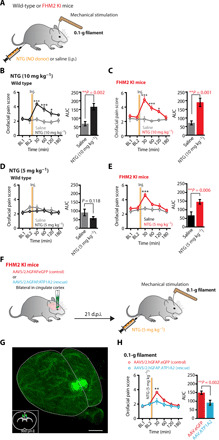
Local rescue of astrocyte dysfunction in the Cg reduces facial pain in FHM2 mice.(A) Schematic illustration of the experimental design. (B) Time course showing the orofacial pain score in WT mice injected with either saline (gray) or NTG (black). NTG (10 mg kg−1) elicits hypersensitivity to touch at 30, 60, and 120 min following injection. (C) Same as (B) but for FHM2 mice injected with saline (gray) or NTG (red). NTG (10 mg kg−1) evokes higher orofacial pain scores at 30, 60, and 120 min following injection. (D) A lower dose of NTG (5 mg kg−1) does not elicit a higher sensitivity in WT mice. (E) In FHM2 mice, NTG (5 mg kg−1) evokes a higher orofacial pain score at 30 min after injection. (F) Schematic illustration of the experimental design. (G) Three-dimensional reconstruction of a cleared brain imaged with light-sheet microscopy showing the volume and site of the injection in Cg after ex vivo fixation. Scale bar, 300 μm. The bottom left image shows a single coronal section, and dots indicate the center of the injection volume of the viruses from six brains. (H) Time course showing the orofacial pain score in FHM2 mice injected with the control virus (red) or the rescue virus (blue). NTG (5 mg kg−1) only evoked a higher orofacial pain score at 30 min after injection in control FHM2 mice and not in rescued FHM2. Data are means ± SEM. Two-way ANOVA with Bonferroni post hoc test and two-tailed unpaired t test were used.